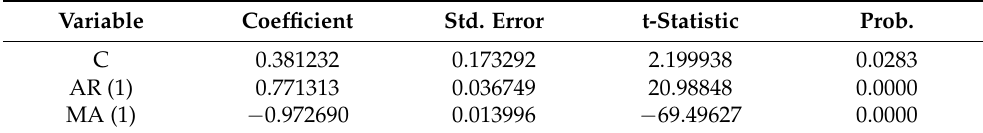
Table 3. Estimated ARIMA